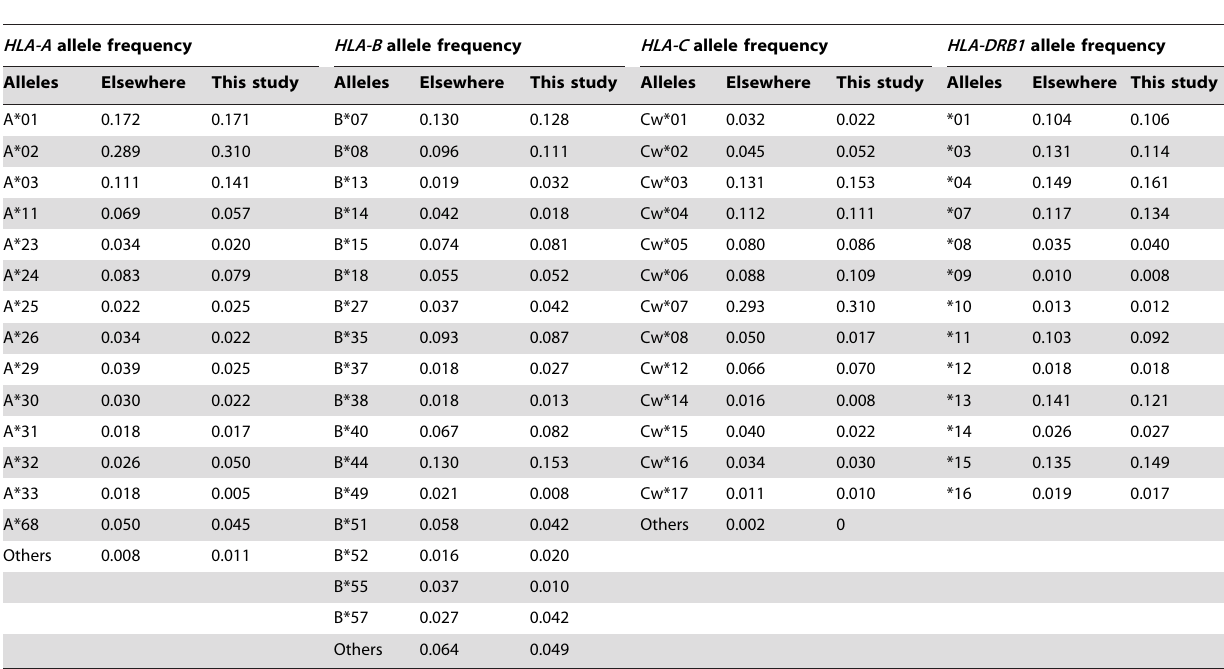
Table 2. Distribution of relatively common HLA-A , - B , - C , and - DRB1 variants in similar case-control populations studied here (this study, N =298) and elsewhere ( N =312).